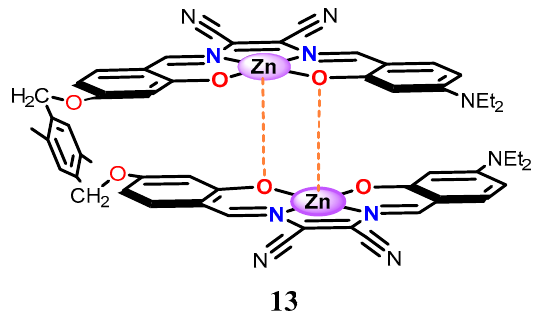
Figure 12. Molecular structure of the intramolecular aggregate dinuclear complex 13.